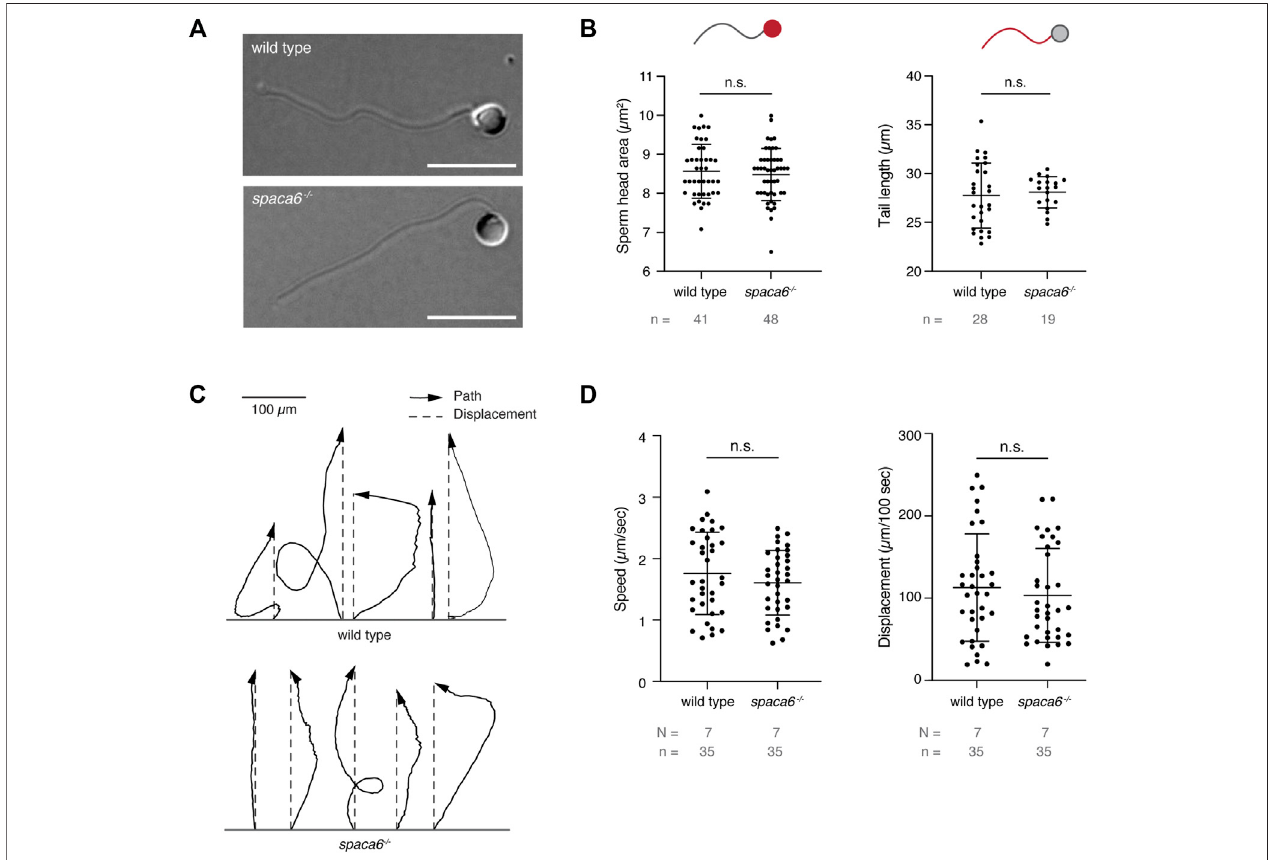
FIGURE 3 | Spaca6 KO sperm is morphologically normal and motile. (A). Representative differential interference contrast (DIC) images of wild-type and spaca6 − / −